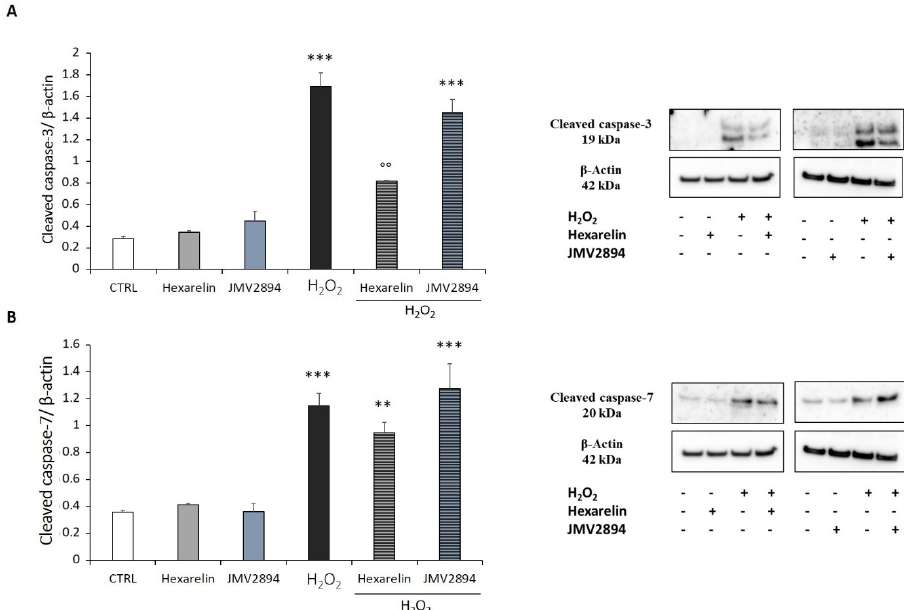
Figure 9. GHS inhibits apoptotic pathway through caspases inactivation. The SH-SY5Y SOD1 G93A cells were treated with H 2 O 2 alone, GHS alone, or with a combination of GHS and H 2 O 2 for 24